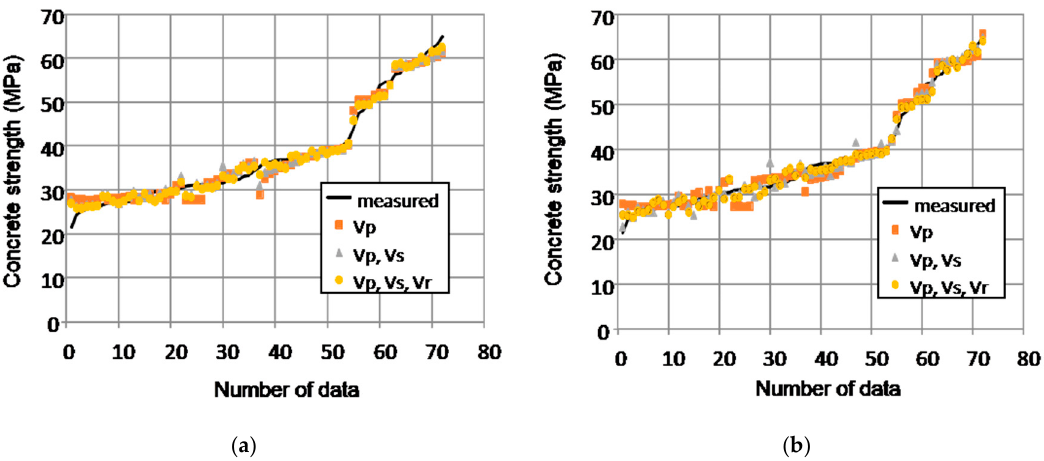
Figure 11. Tracking of measured concrete strength by SVM and ANN. ( a ) SVM; ( b ) ANN.